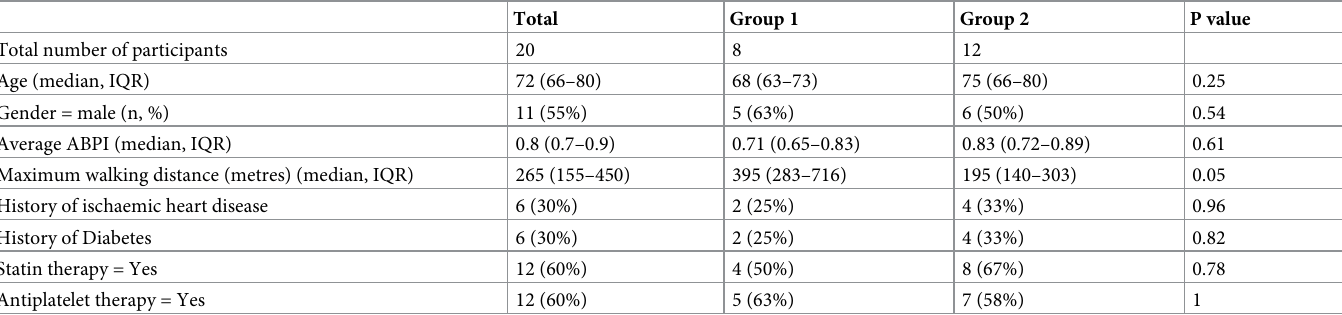
Table 1. Summary of patient